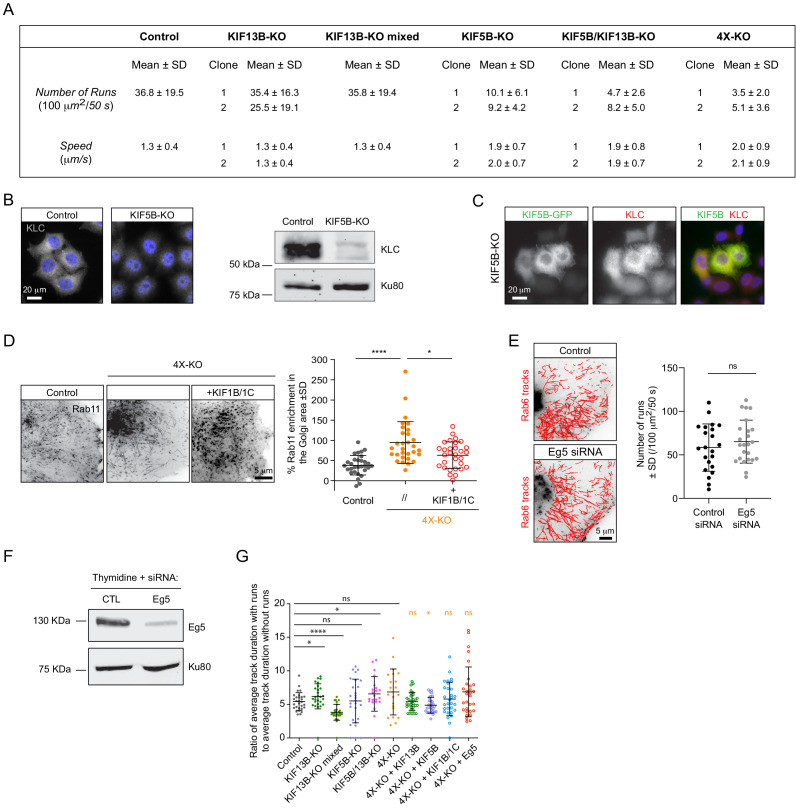
Characterization of kinesin knockout cell lines.(A) Table summarizing parameters of Rab6 vesicle runs (number and speed) in two independent HeLa cell clones for each kinesin knockout. Data for the mixed population of KIF13B-KO cells is included for comparison. KIF13B-KO clone #1, KIF5B-KO clone #1, KIF5B/KIF13B-KO clone #1 and 4X-KO clone #2 have been used in latter experiments. (B) Impact of KIF5B-KO on the expression of kinesin light chain (KLC) assessed by immunostaining with a KLC antibody and Western blotting. (C) Representative images of KIF5B-KO HeLa cells expressing a KIF5B-GFP construct and stained for KLC. (D) Analysis of Rab11 tracks in control and 4X-KO HeLa cells or 4X-KO cells expressing KIF1B and KIF1C. Maximum intensity projections (500 consecutive frames, 100 ms interval) of GFP-Rab11 were used to calculate the enrichment of Rab11 signal in the perinuclear region as described in Methods. n = 30 cells for each condition in three independent experiments. Mann-Whitney U test: ****p<0.0001, *p=0.0225. (E) Automatic tracking with SOS/MTrackJ plugin of GFP-Rab6A labeled vesicles imaged by TIRFM and quantification of the number of Rab6 vesicle runs in HeLa cells transfected with control or Eg5 siRNA and treated with thymidine to prevent mitotic entry. Number of runs in control is a bit high compared to controls in Figure 2D,F. We attribute this difference to the transfection of control Luciferase siRNA and slightly different acquisition settings. n = 22 and 24 cells in two independent experiments. Unpaired t-test: ns, no significant difference. (F) Western blot demonstrating Eg5 knockdown efficiency in HeLa cells using an antibody against Eg5. (G) Total number of tracks per cell. n = 29, 27, 30, 27, 22, 21, 30, 30, 30 and 30 cells, respectively, in two independent experiments for Eg5 and 3 independent experiments in all other conditions. The dataset is the same as in Figure 2G. Mann-Whitney U test: ****p<0.0001; *p=0.0122; ns, no significant difference. (H) Ratio of average duration of tracks with runs to average duration of tracks without runs, per cell. The dataset is the same as in Figure 2G. Mann-Whitney U test: ****p<0.0001; *p<0.032; ns, no significant difference.Figure 2—figure supplement 2—source data 1.An Excel sheet with numerical data on the quantification of Rab11 enrichment in the Golgi area in 4X-KO and in 4X-KO re-expressing KIF1B/1C, the effect of Eg5 depletion on the number of vesicle runs, and the effect of kinesin silencing and rescue on the average track duration with runs represented as plots in Figure 2—figure supplement 2D,E,G.